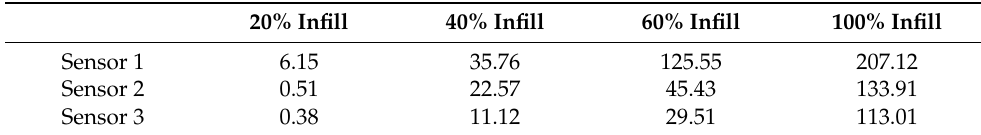
Table 2. Calculated SSD for baseline conditions at two different times.